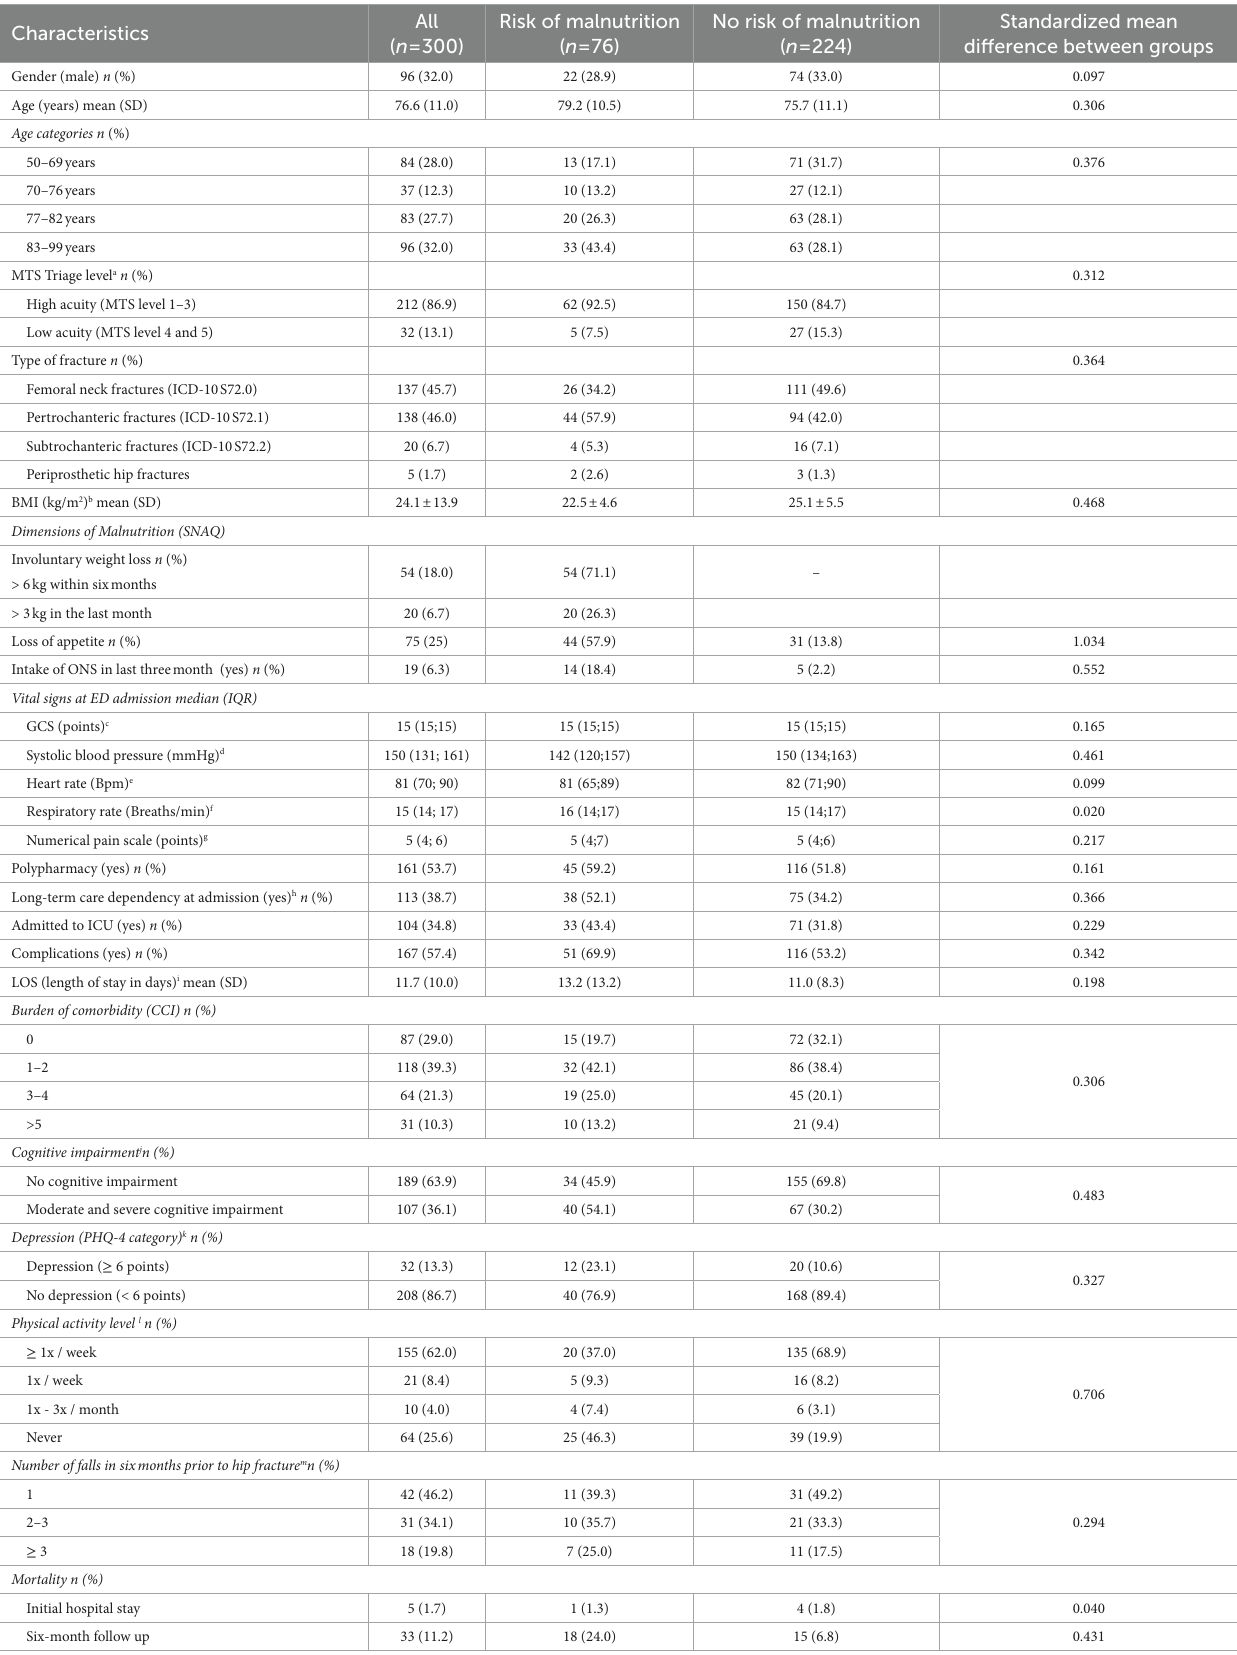
TABLE 1 Characteristics of ED patients with hip fracture screened for malnutrition. Characteristics